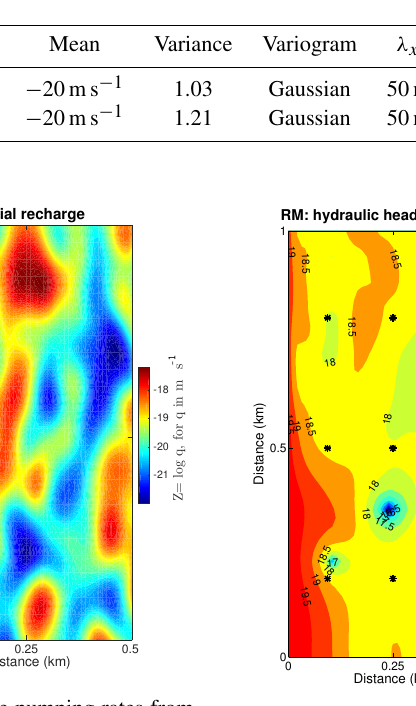
Figure 3. Groundwater flow contour maps obtained using the refer- ence run (left panel) and the perturbed forecast model (right panel) after 18 months of simulation. The well locations from which head data are extracted are shown by black asterisks. In the left panel, we show the first network consisting of nine wells. In the right panel, the other network with 25 wells is